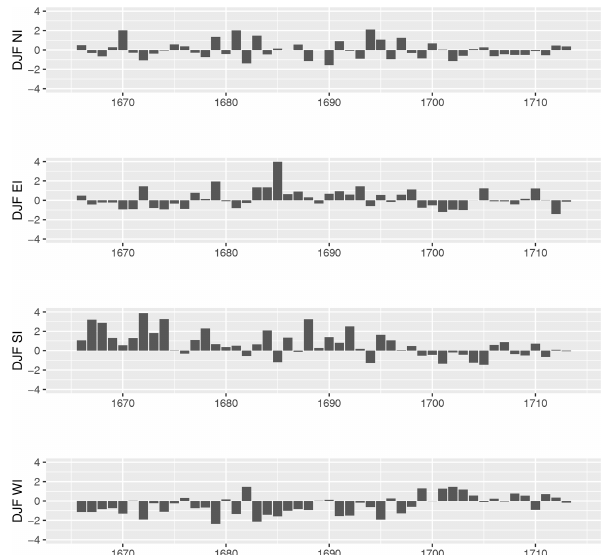
Figure A4. Standardized DJF DI time series for the LMM (1665– 1713) with respect to the mean of the reference period of 1981– 2010.